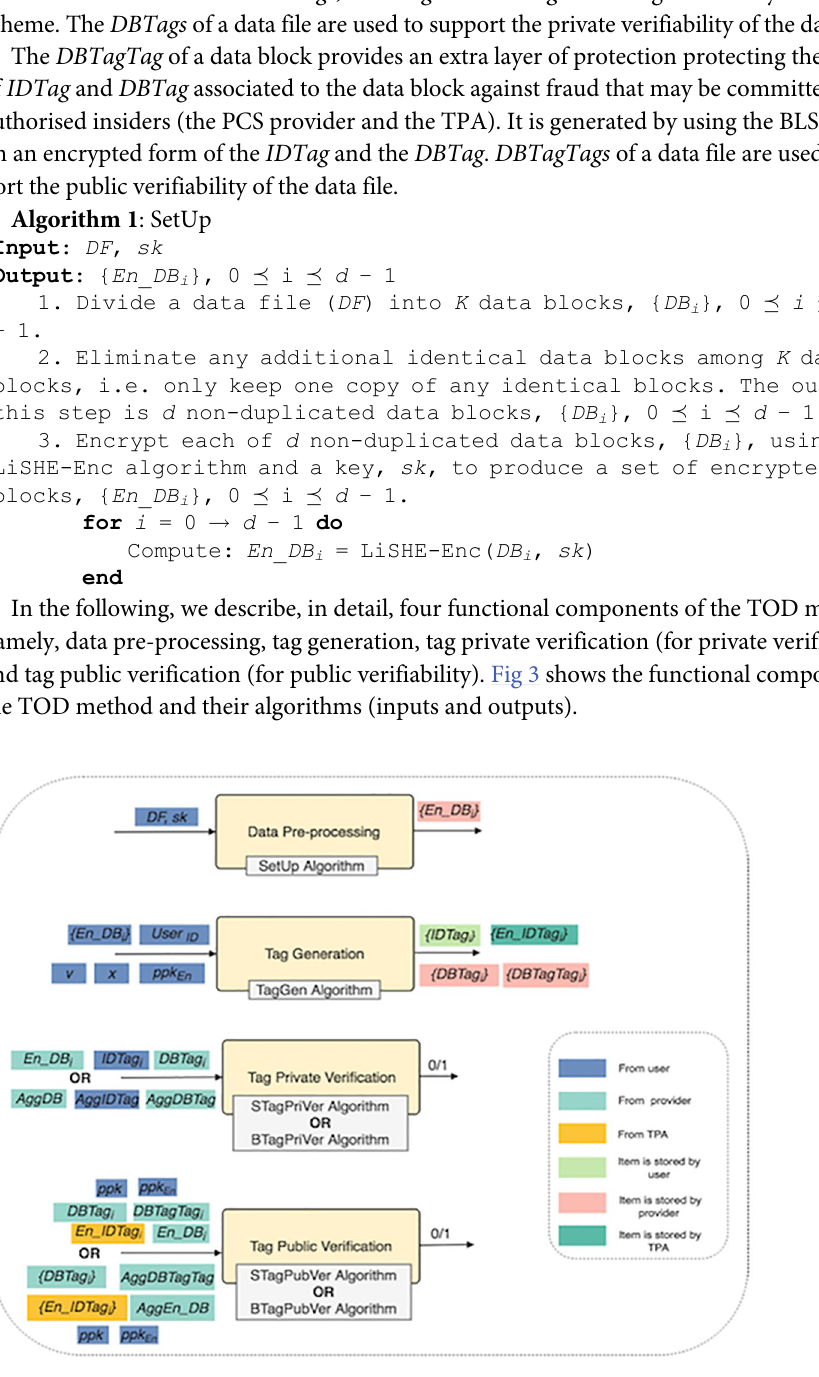
Fig 3. The functional components of the TOD